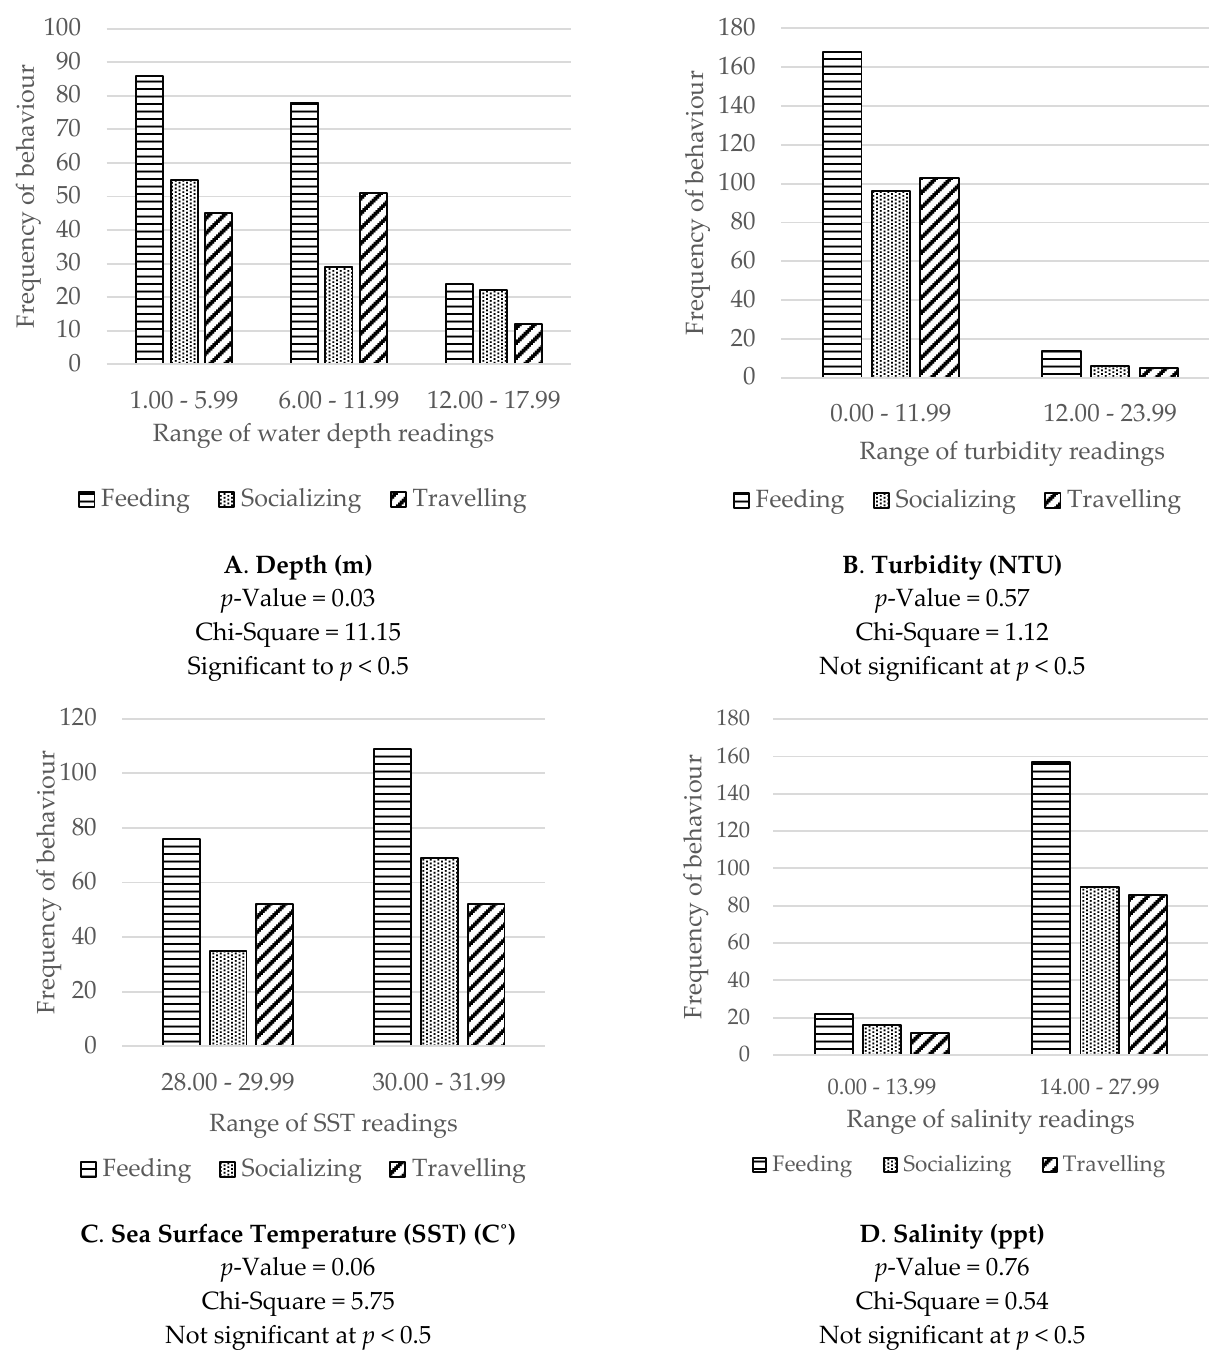
Figure 7. The frequency of behavioural categories (feeding, travelling and socializing) versus the ranges of abiotic factors (depth ( A ), turbidity ( B ), sea surface temperature ( C ) and salinity ( D )).